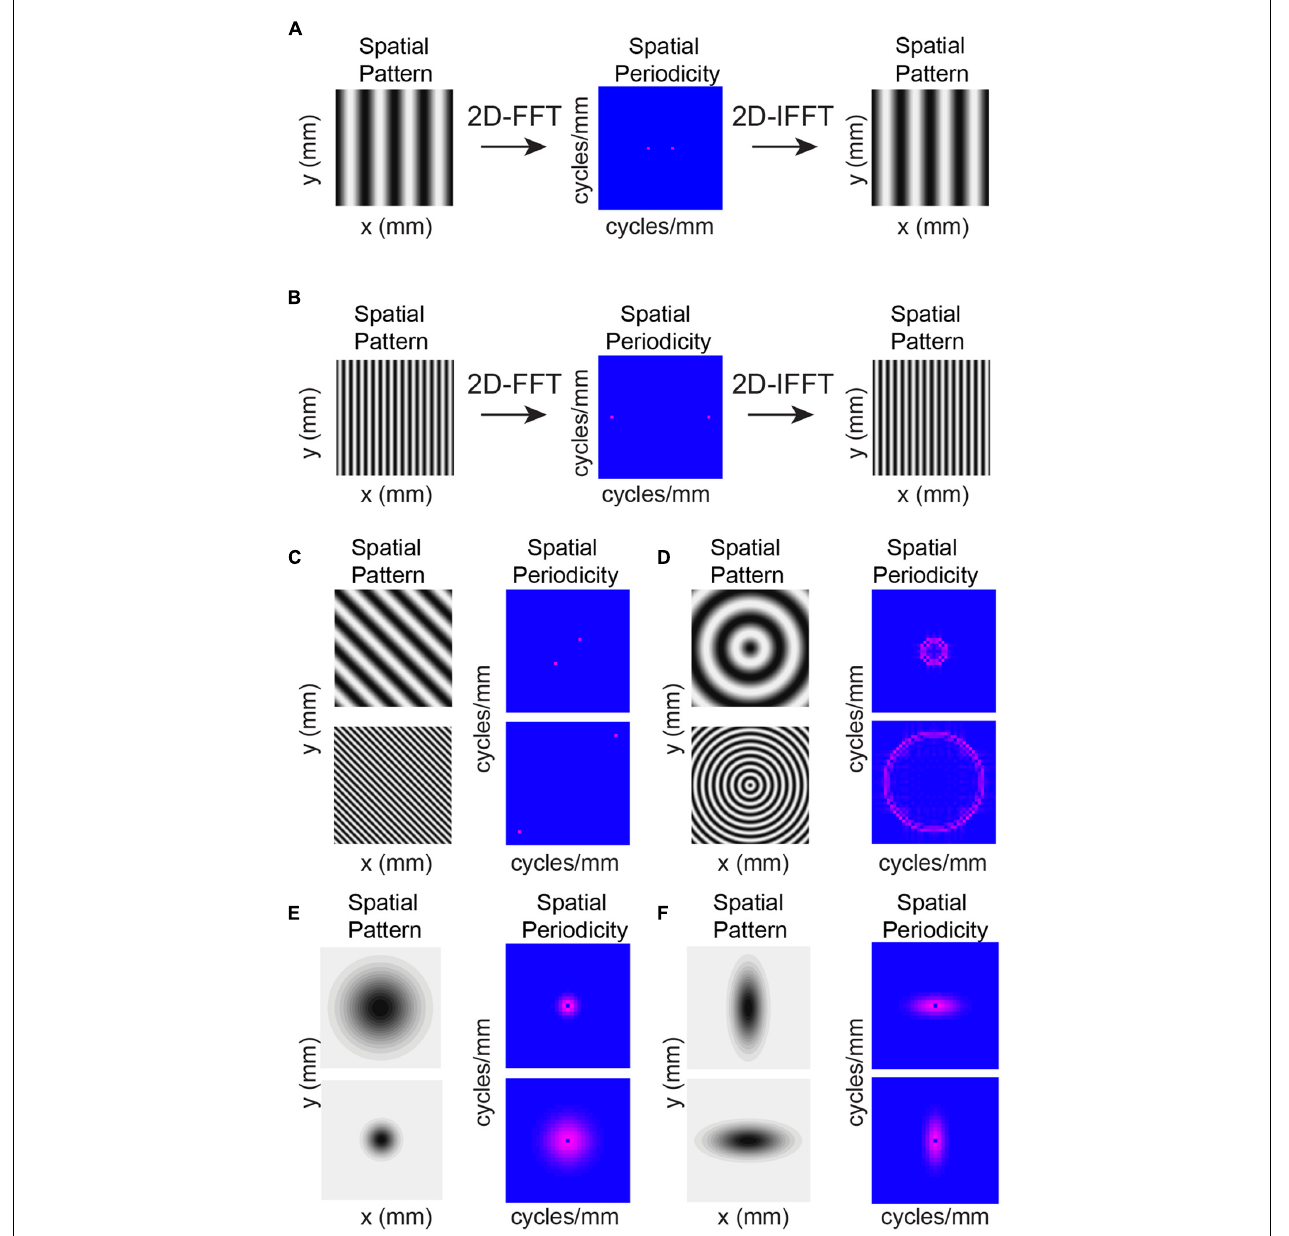
FIGURE 5 | Example 2D Fourier Analysis (FFT) images demonstrate conversion from space to spatial periodicity. Analysis applied to connection probability maps demonstrate significant periodicities. (A,B) Sample 2D FFTs. Simple oriented gratings result in single points in spatial periodicity with higher frequency gratings resulting in higher frequency spatial components. Applying the inverse 2D FFT (IFFT) recreates the original image with these spatial